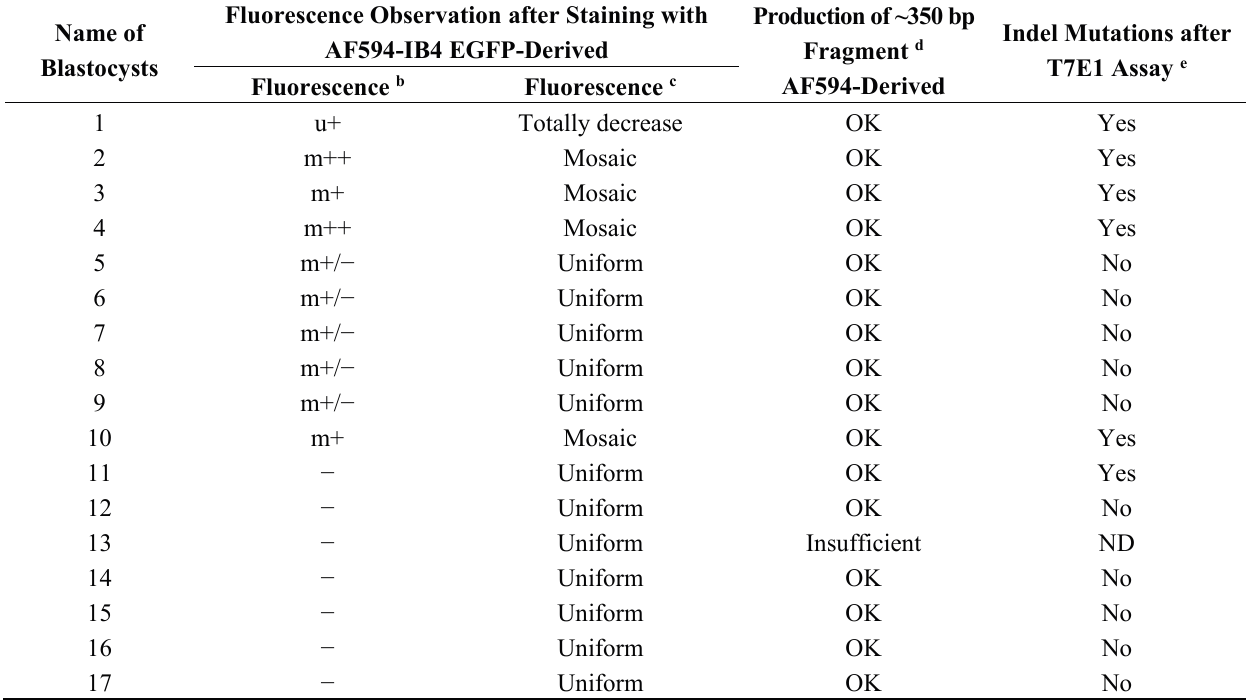
Table 1. Summary of the properties of blastocysts derived from